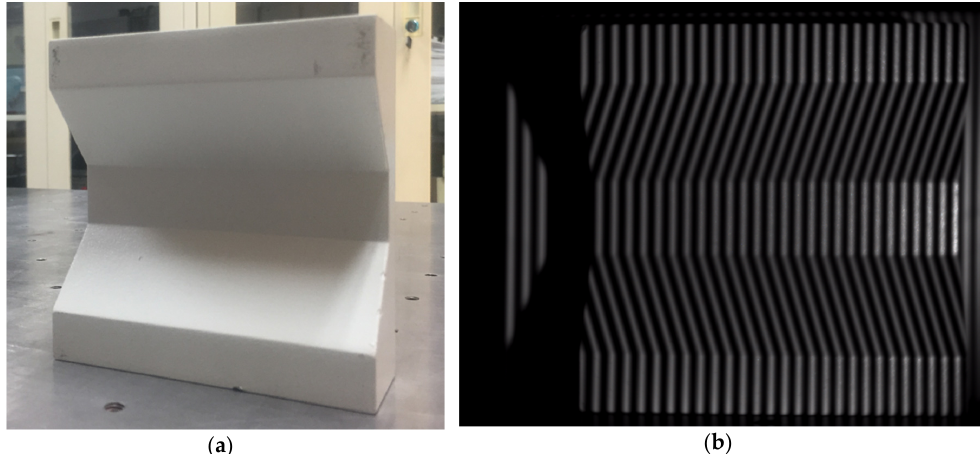
Figure 4. ( a ) Measured object; ( b ) grating fringe pattern of the measured object.